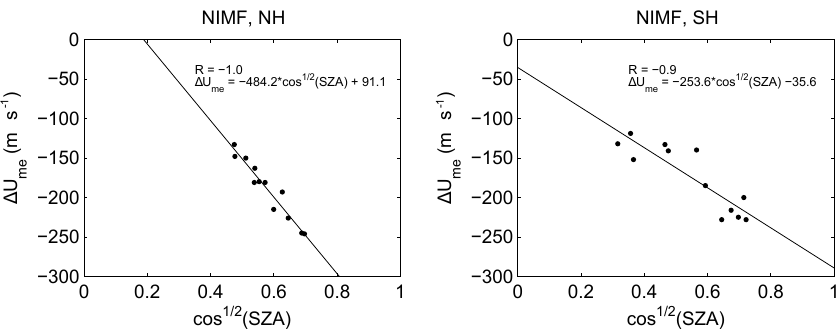
Figure 8. A correlation analysis of the strongest westward disturbance neutral wind with cos 1 / 2 (SZA) in both hemispheres during northward IMF periods. The correlation coefficient ( R ) and linear relationship between the parameters are shown in each plot.